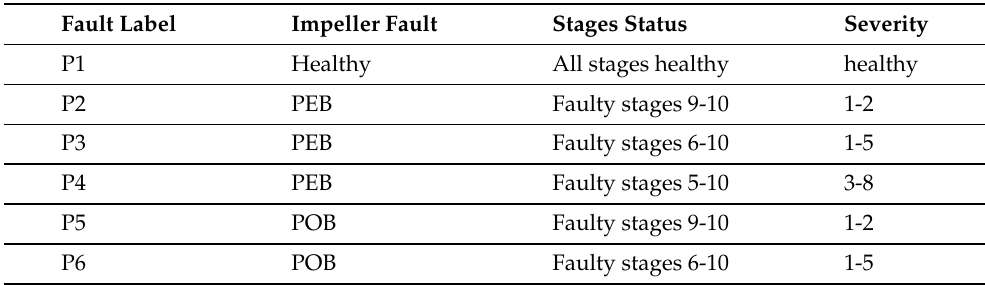
Table 1. Faults conditions in the